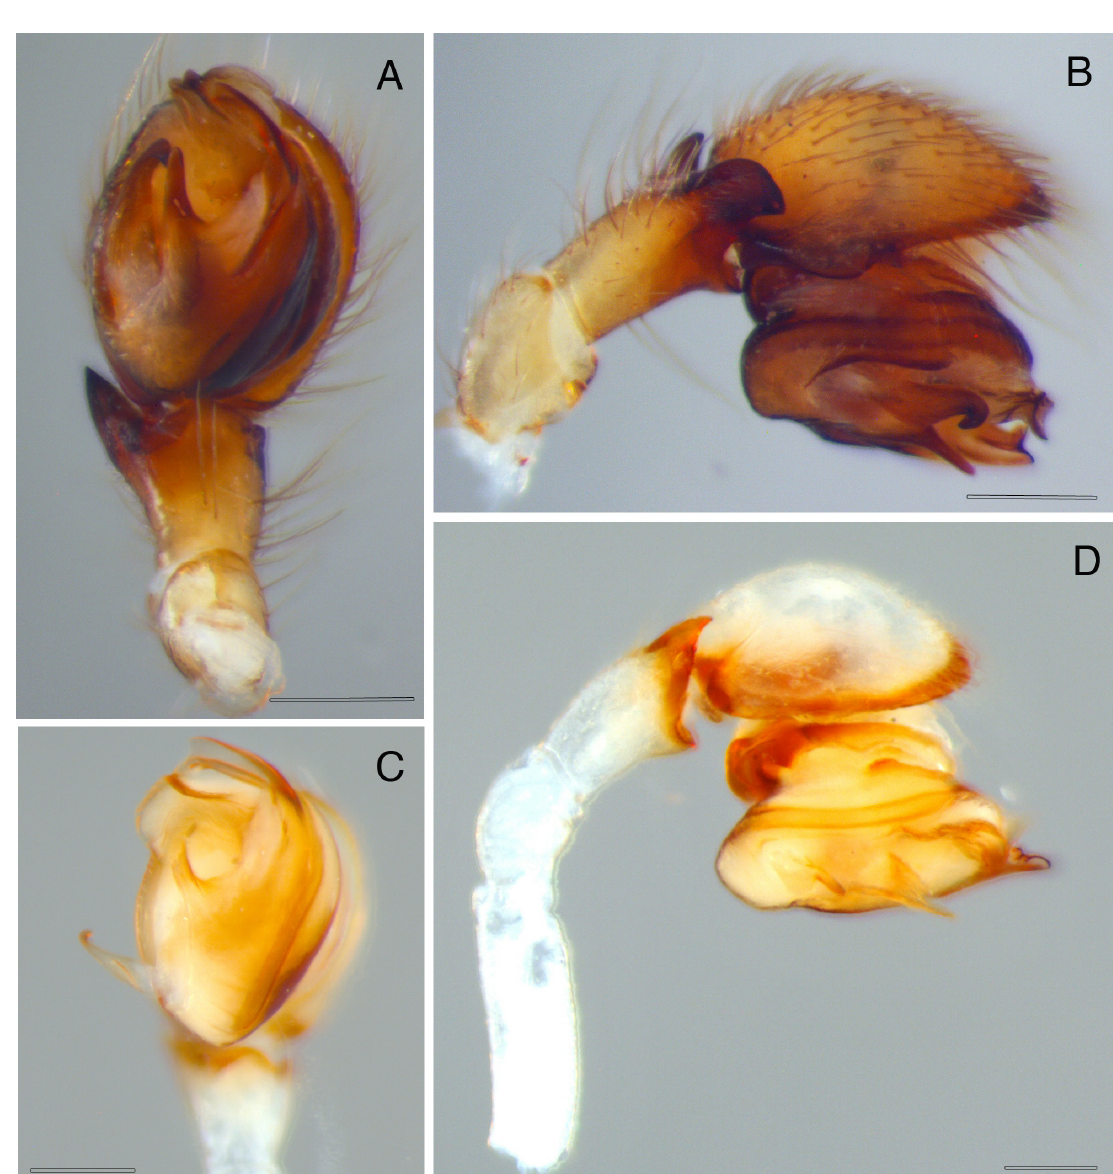
Fig. 2. – A-B . Cyrioctea sawadee sp. nov., ♂ . A . Palp, ventral view. B . Idem, retrolateral view. – C-D . Cyrioctea lotzi sp. nov., ♂ . C. Palp, ventral view. D . Idem, retrolateral view. (Scale bars: 200